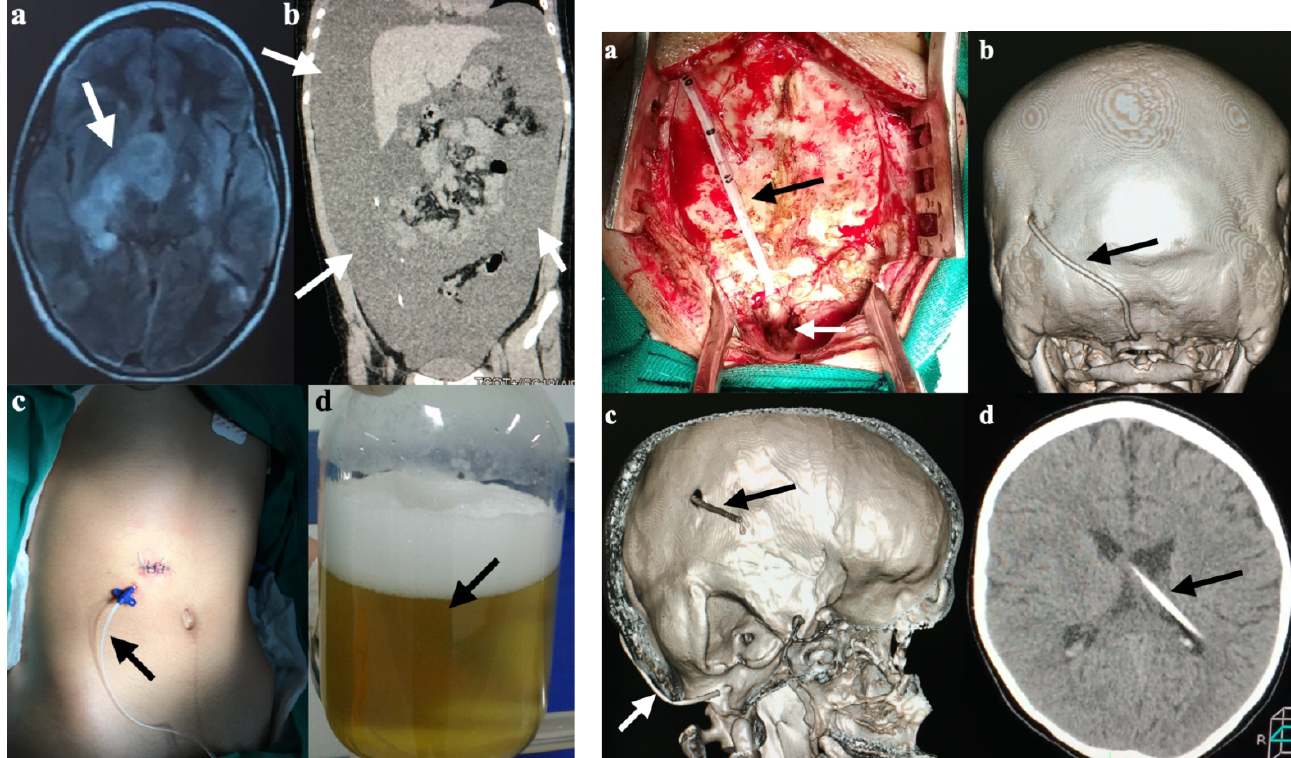
Figure 1 - (a) FLAIR (Fluid Acquisition Inversion Recovery) Magnetic Resonance sequence showing the optic-pathway glioma (white arrow); (b) Non-contrast coronal computed tomography of the abdomen showing ascites (white arrows); (c) Exposure of the distal extremity of the ventriculoperitoneal catheter in the abdomen; (d) Drained ascitic fluid (black arrow)